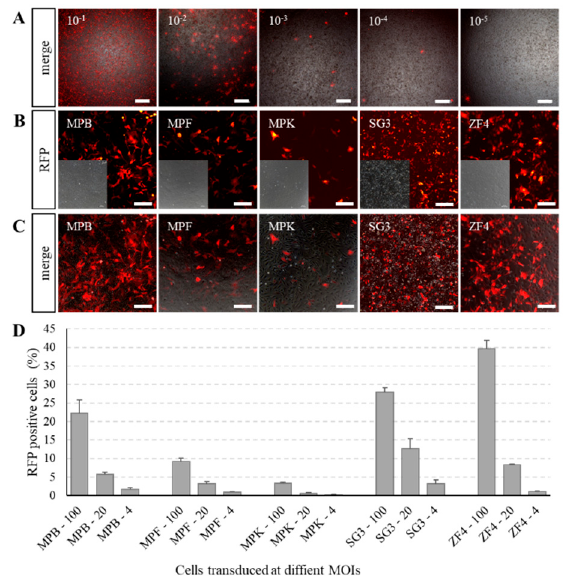
Figure 2. Cells transduced with recombinant baculovirus. ( A ) Titer determination by end-point dilution method based on RFP fluorescence. Baculoviral stocks diluted from 10 − 2 to 10 − 8 times with 10 µ L were added to a 96-well plate. The number on the upper left corner of each image is the volume ( µ L) of original baculoviral stock added to each well. Scale bars, 400 µ m. ( B , C ) Expression of RFP in Mylopharyngodon piceus bladder (MPB), fin (MPF), and kidney (MPK); Oryzias latipes spermatogonia (SG3); and Danio rerio embryonic fibroblast (ZF4) cells transduced with BV-CMV-ie1-pr at a multiplicity of infection (MOI) of 20. The expression of RFP was observed under an inverted fluorescence microscope after 3 days of transduction. Scale bars, 200 µ m. ( D ) Transduction efficiencies of BV-CMV-ie1-pr in MPB, MPF, MPK, SG3, and ZF4 cells at different MOIs. The transduced efficiencies were determined by counting RFP-positive cells under an inverted fluorescence microscope at 3 days post-transduction in triplicate. The number after the cell name is the corresponding incubation dose in MOI. Values are indicated as mean ± SD.